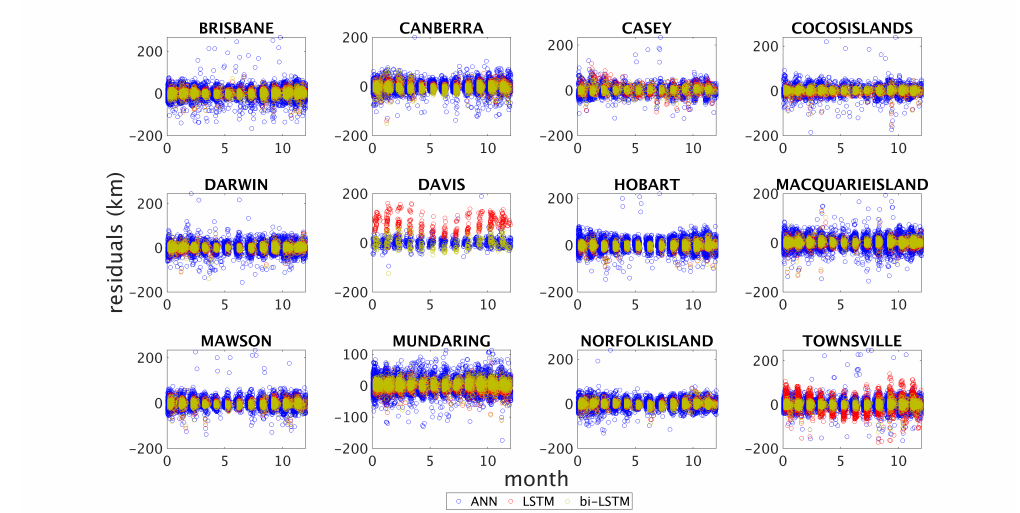
Figure 11. Residuals of the ANN, LSTM and bi-LSTM models in relation to the time at 12 different ionosonde stations. Each panel is for one station. Blue, red and yellow circle in panels denote the residuals from ANN, LSTM and bi-LSTM respectively. In each panel, X axis is month and Y is residual